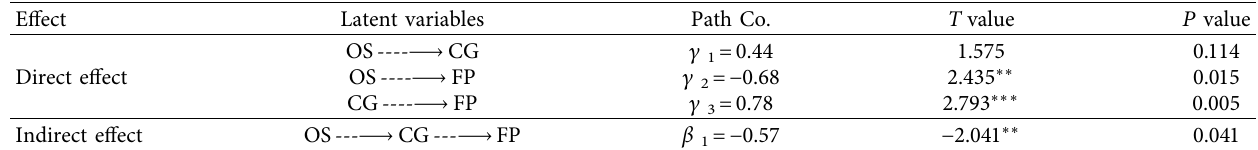
Table 8: The effect of latent variables on each other.